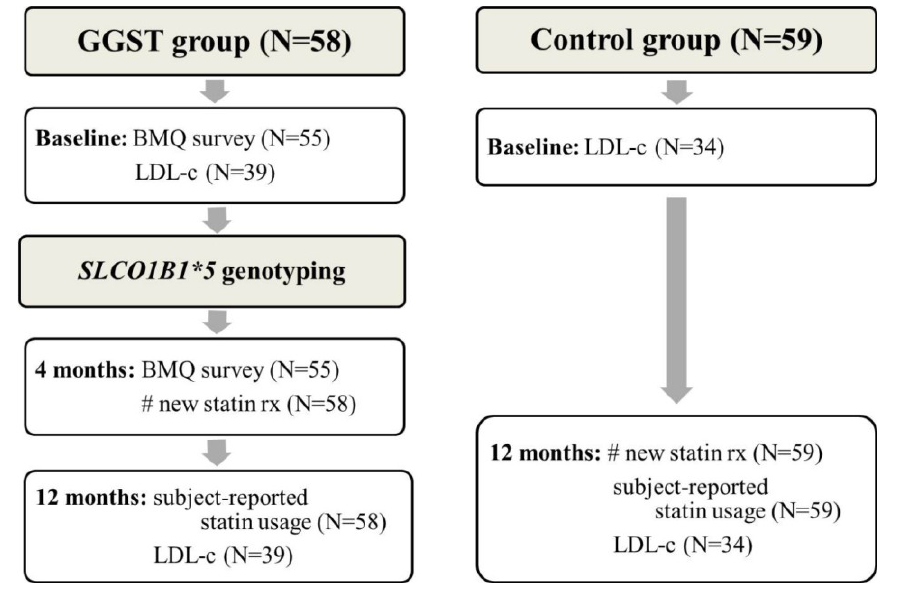
Figure 1. Flow diagram illustrating study design and outcome measures for individuals in the GGST and control groups. GGST = genotype guided statin therapy; BMQ = Beliefs about Medications Questionnaire; LDL-c = low-density lipoprotein